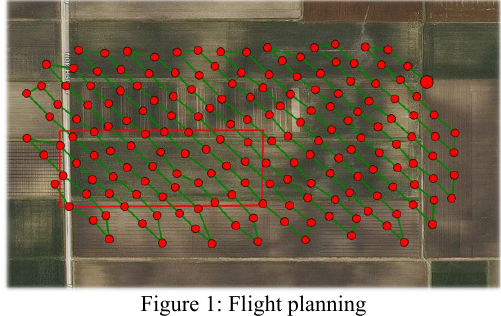
Figure 1: Flight